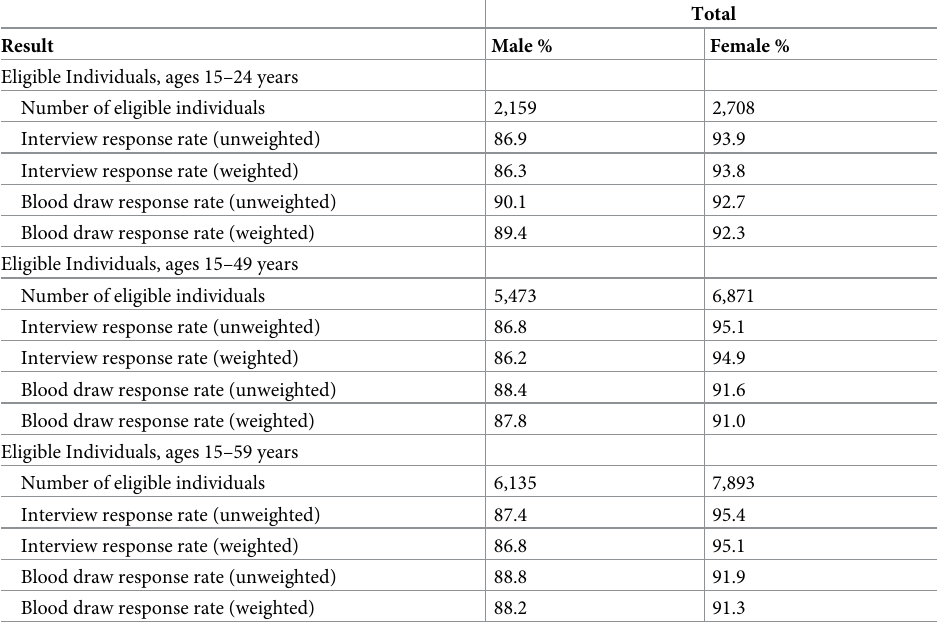
Table 1. Interview and blood draw response rates amongst participants aged 15–59 years, Lesotho Population- based HIV Impact Assessment